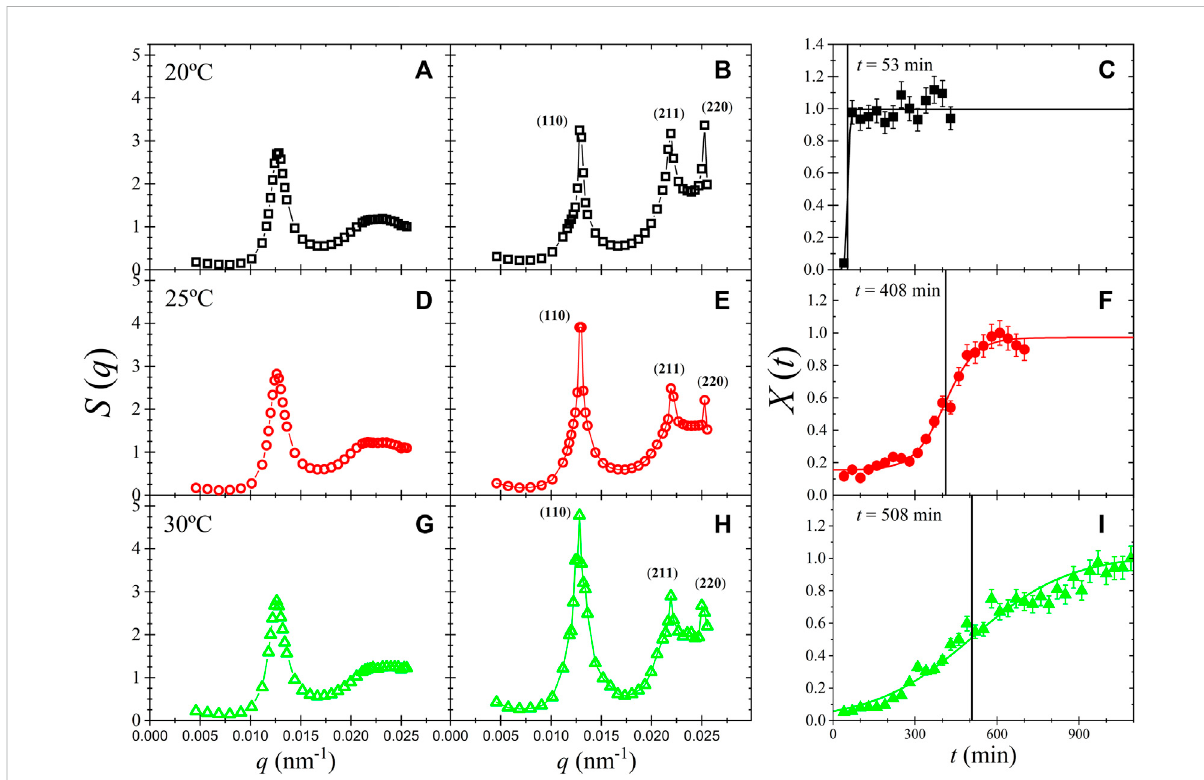
FIGURE 3 (A) Initial measured static structure factor, S ( q ), right after quenching, (B) Final equilibrium static structure, (C) time evolution of the degree of crystallinity(symbols)alongwithaBoltzmann fi t(continuousline)at20 ° C. (D) Initial S ( q )rightafterquenching, (E) Finalequilibriumstaticstructure, (F) time evolution of the degree of crystallinity (symbols) along with a Boltzmann fi t (continuous line) at 25 ° C. (G) Initial S ( q ) right after quenching, (H) Finalequilibriumstaticstructure, (I) timeevolutionofthedegreeofcrystallinity(symbols)alongwithaBoltzmann fi t(continuousline)at30 ° Cfor sample KPS0.1 at n = 5.94 particles/µm 3